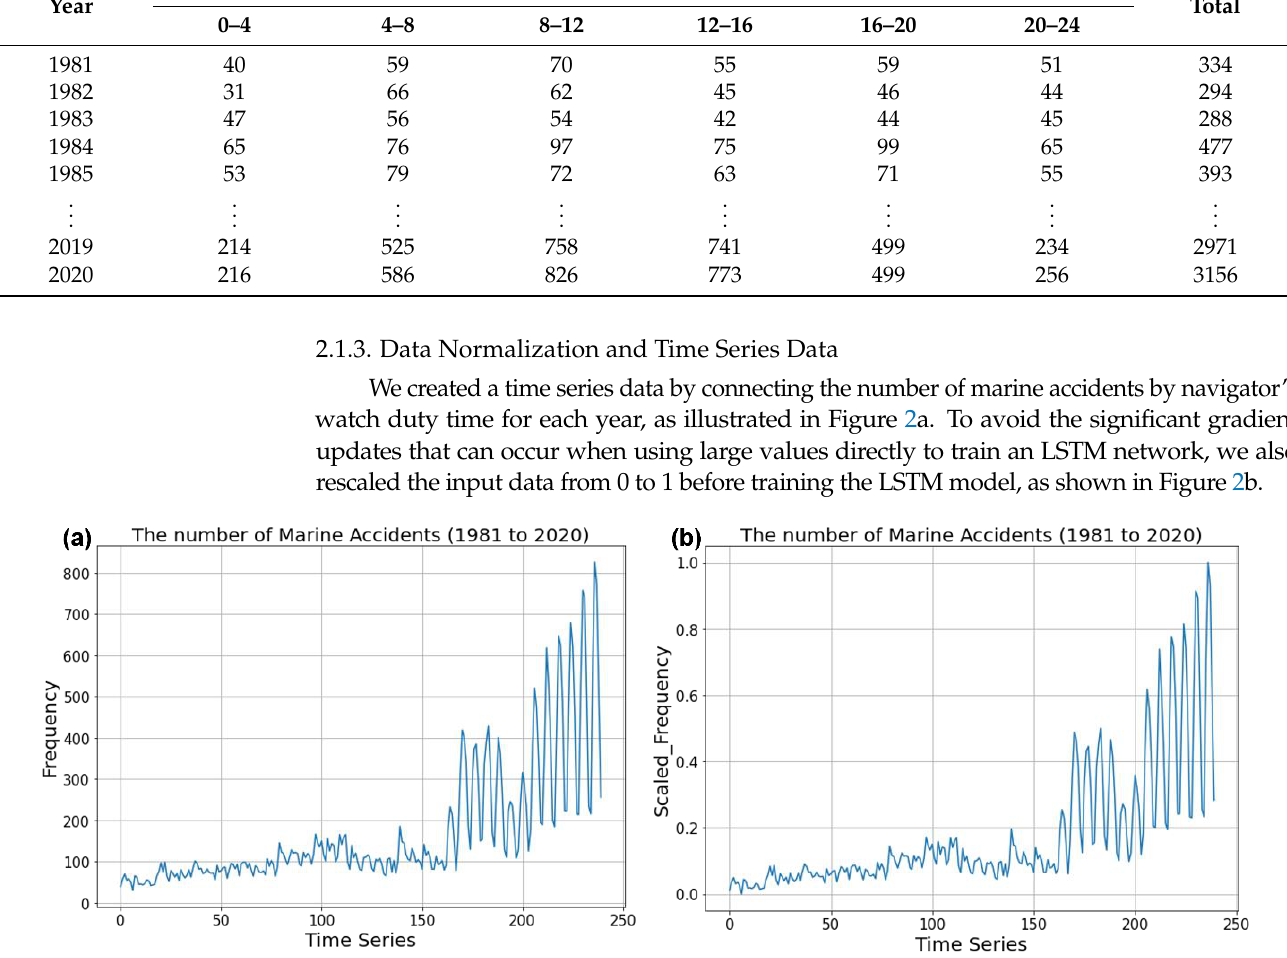
Figure 2. Time series of marine accidents from 1981 to 2020 for: ( a ) original data; ( b ) rescaled data.